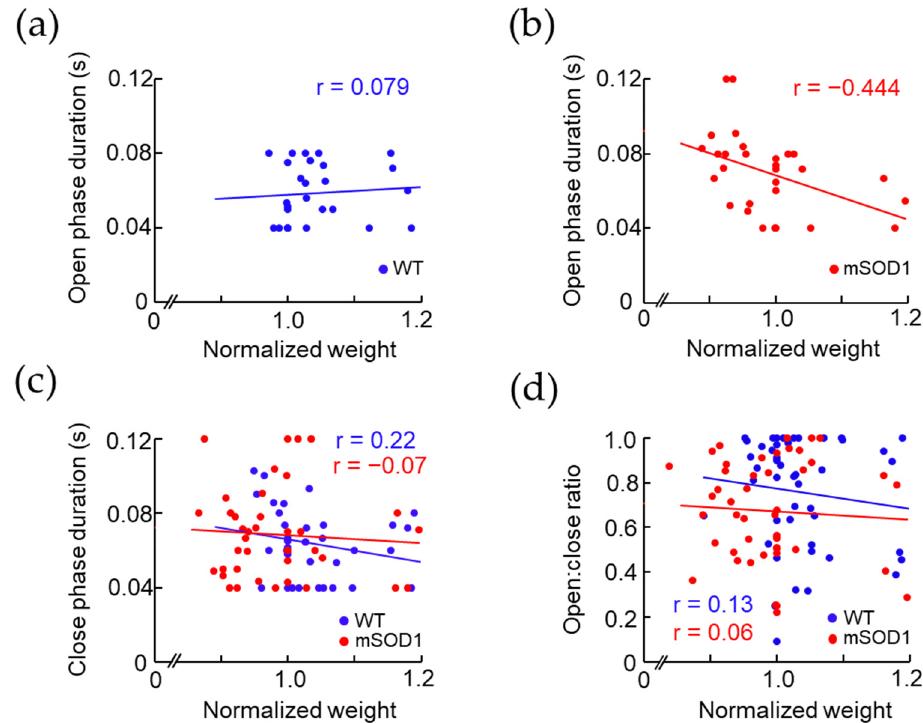
Figure 5. Correlation between body weight and the opening and closing mouth movements in ALS model mice after 12 weeks of age. The relationship between normalized body weight and open phase and close phase duration after 12 weeks of age is shown. ( a , b ) Despite no correlation between normalized body weight and open phase duration in WT, a negative correlation was observed in mSOD1. ( c , d ) No correlation between normalized body weight and close phase or open:close ratio was observed in WT and mSOD1.